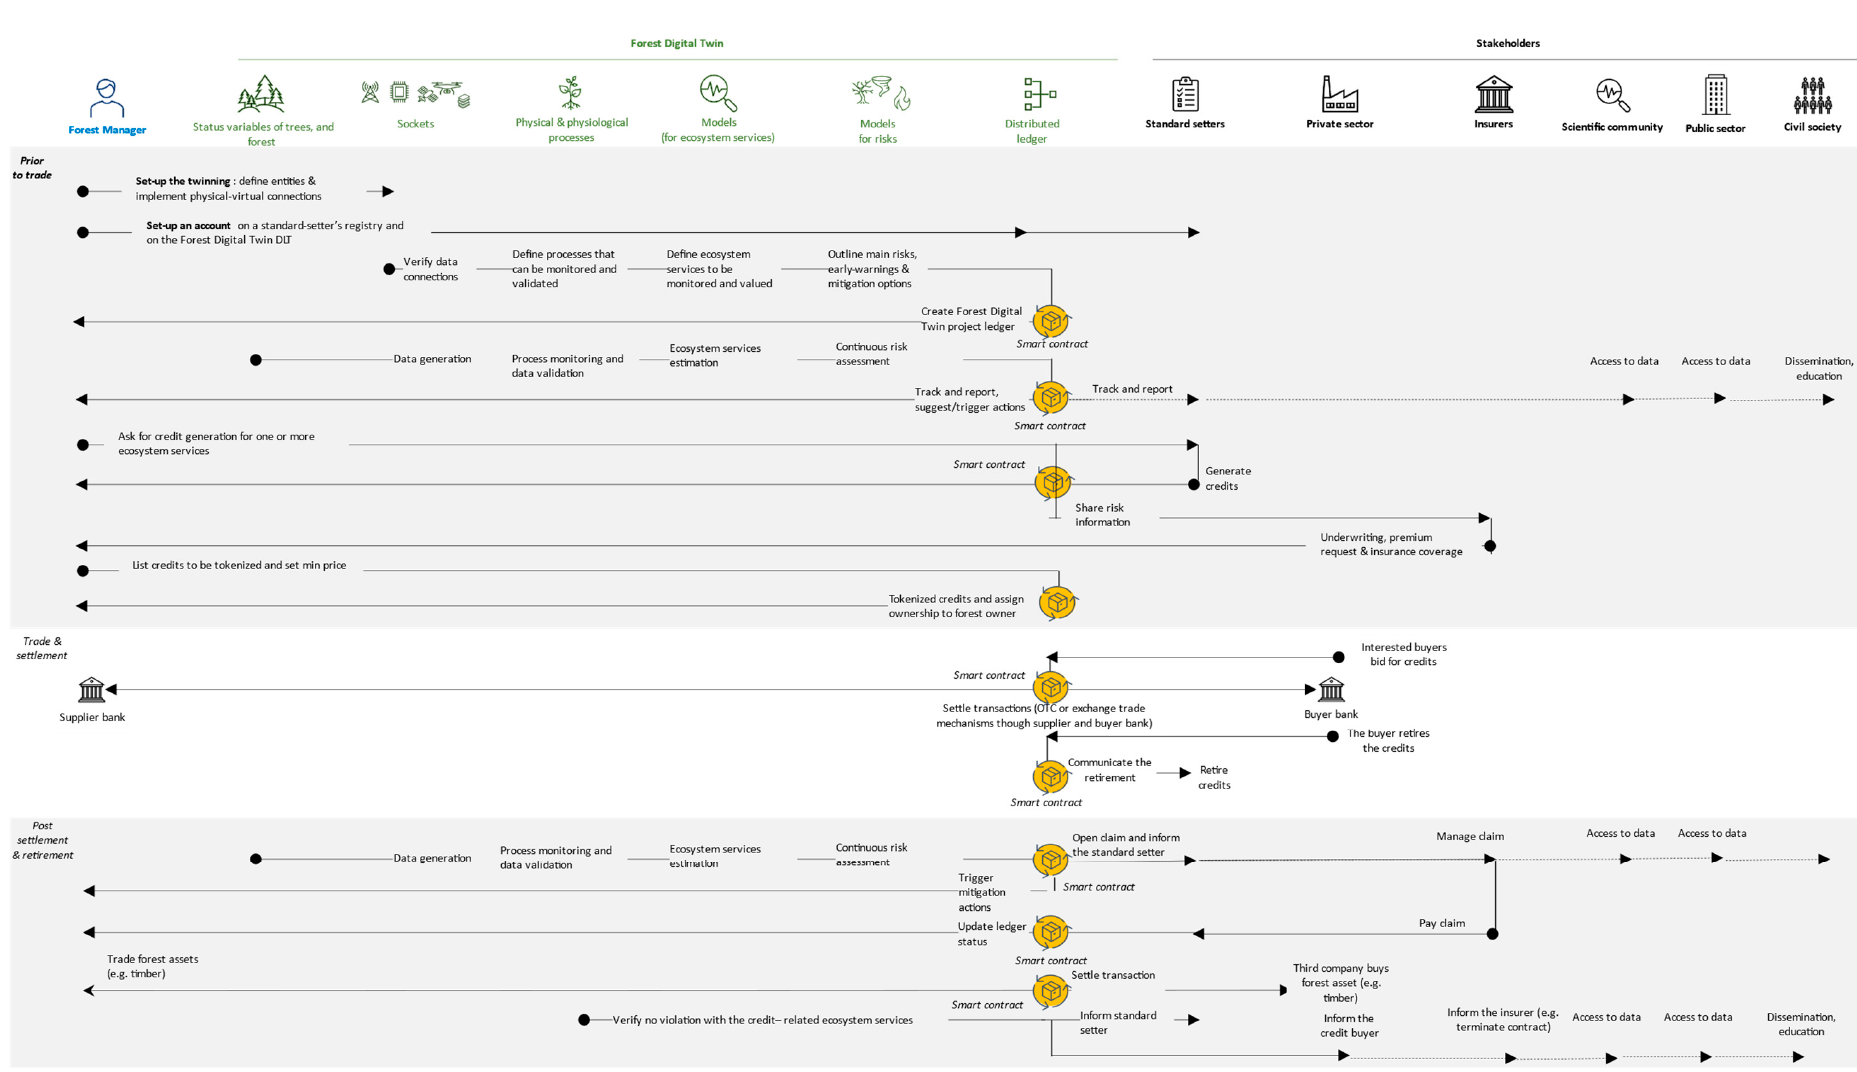
Figure 2. An end-to-end theoretical application of a forest digital twin.